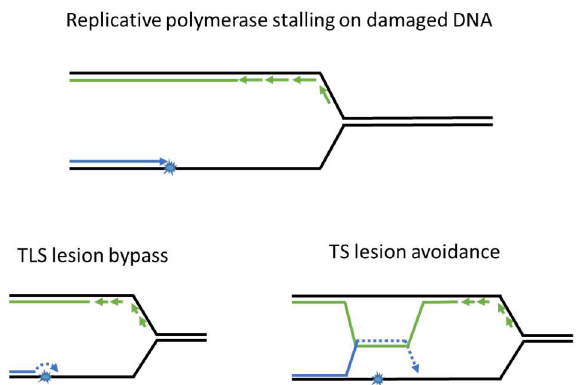
Figure 3. Post replication repair efficiently returns lesions in ssDNA to double helix. PRR utilizes trans-lesion synthesis (TLS) or template switching (TS) to bypass or avoid DNA lesions and prevent accumulation of ssDNA gaps. After being restored to its double-stranded state, damaged DNA may be repaired via the mechanisms described in Figure 1.